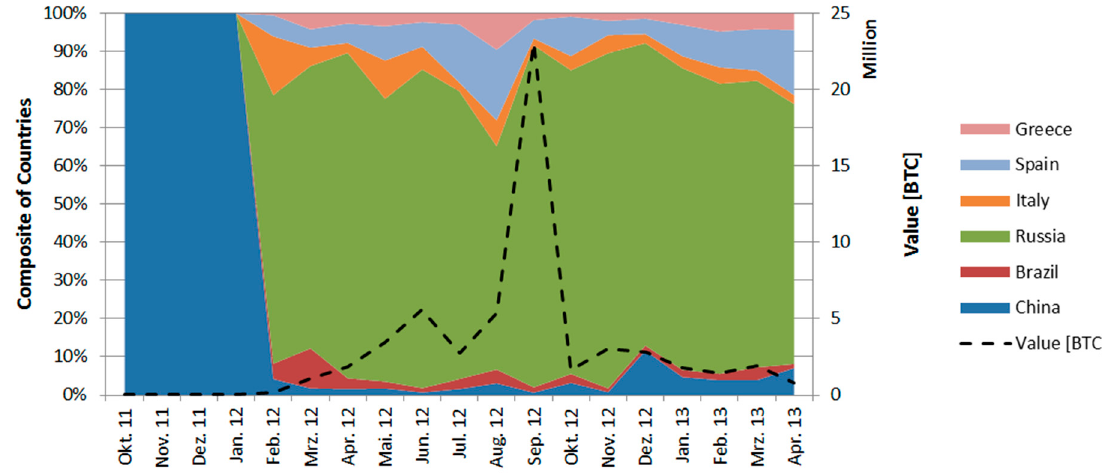
Figure 17. Composite of Emerging Countries over Time (Value in BTC).